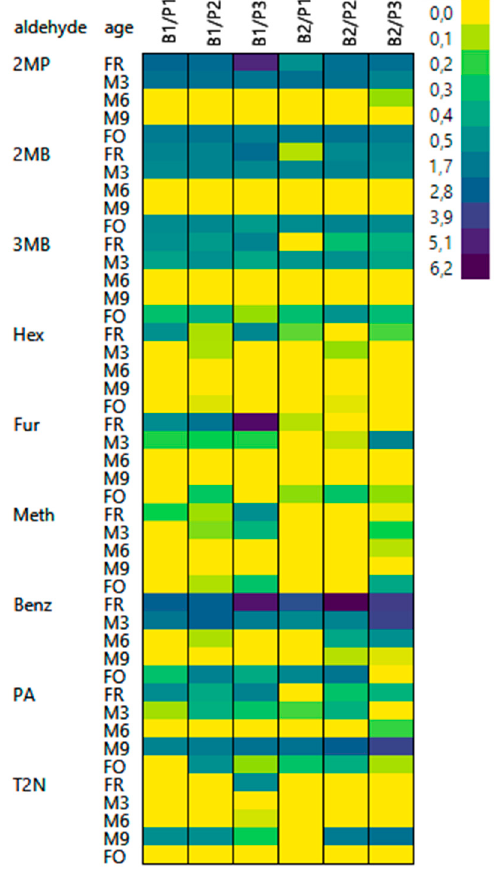
Figure 4. ACA-releasable aldehydes ( n = 6): heatmap shows relative concentration of bound state aldehydes in comparison to the free form (B1: barley variety 1; B2: barley variety 2; P1: low proteolytic malt modification; P2: medium proteolytic malt modification; P3: high proteolytic malt modification).